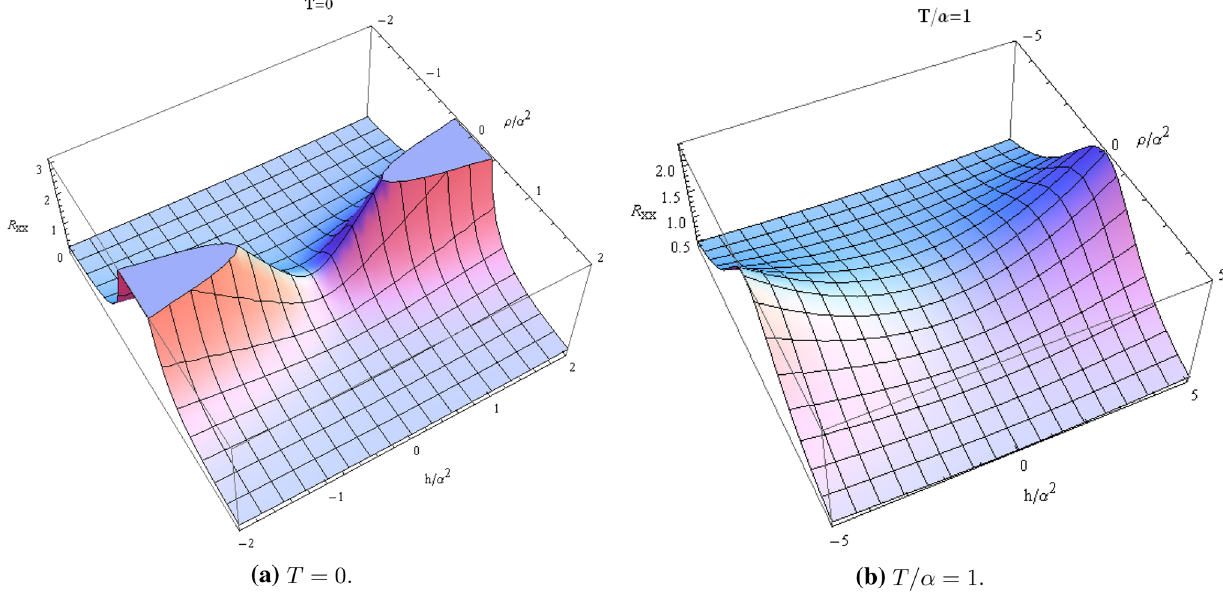
Fig. 2 The resistance R xx versus ρ/ a 2 and h / a 2 at T = 0 and T /α = 1 for Maxwell